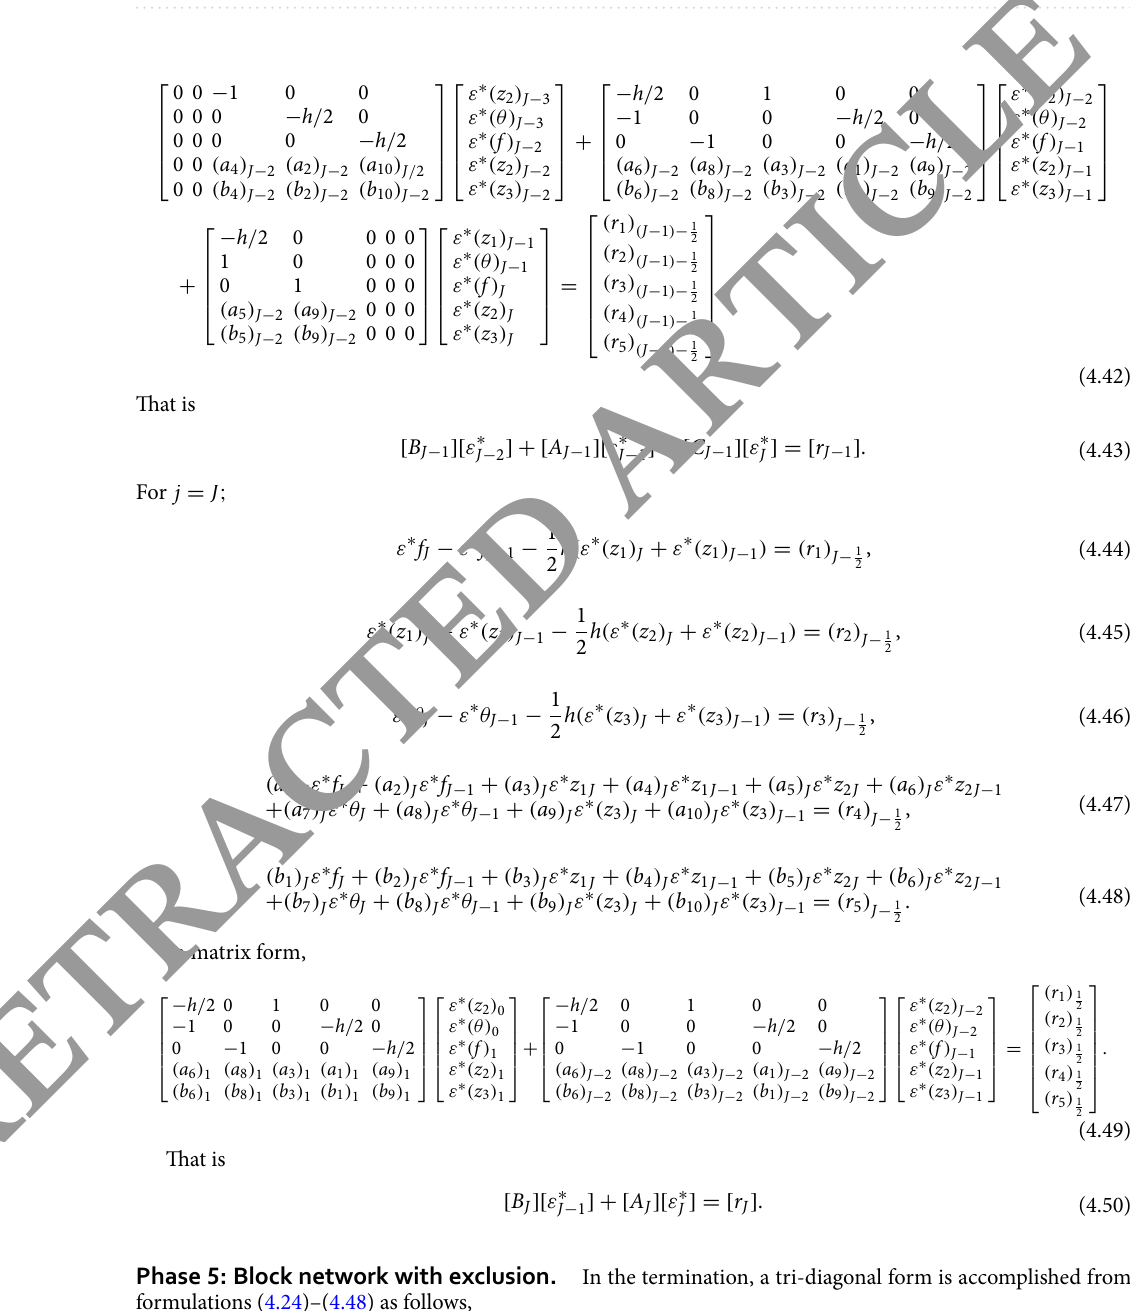
Table 5. Evaluation of 0 , S = 0 and B E c =